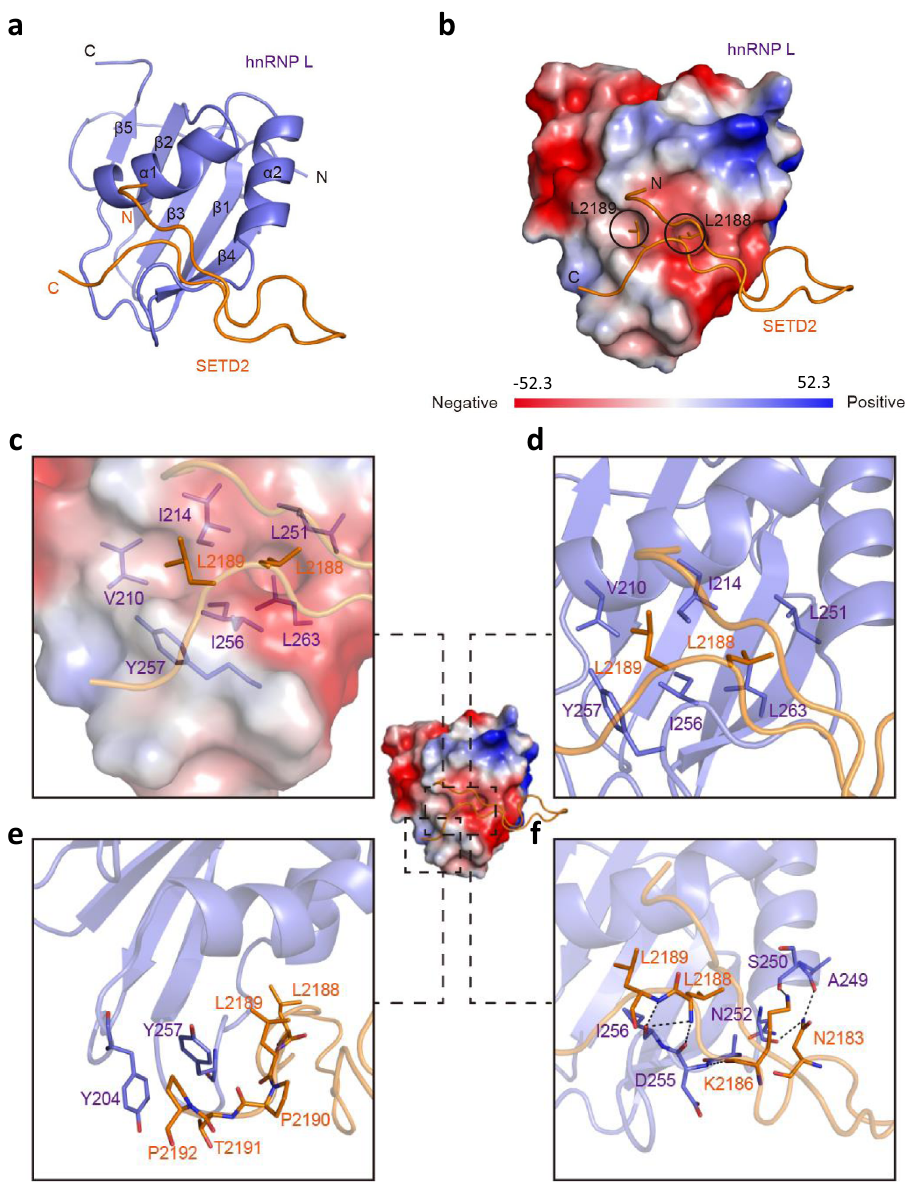
Fig. 2 The crystal structure reveals the molecular basis of hnRNP L-SETD2 interaction. a Ribbon representations of hnRNP L RRM2 bound to the SETD2 2167 – 2192 peptide. hnRNP L is colored in purple and the bound SETD2 2167 – 2192 peptide is colored in orange. b The SETD2 2167 – 2192 peptide is represented as ribbons on the molecular face of hnRNP L RRM2. The sidechains of SETD2 Leu2188 and SETD2 Leu2189 are shown as sticks. Red and blue colors denote negative and positive surface charges, respectively. The electrostatic potential surfaces were generated with PyMol at the contouring value of the potential from − 52.3 to 52.3 kTe − 1 . c – f Closeup views of the interactions between hnRNP L and the SETD2 2167 – 2192 peptide. (Left) The van der Waals surface views of hnRNP L-SETD2 2167 – 2192 . hnRNP L (purple) and SETD2 2167 – 2192 (orange) are shown as ribbons with selected sidechains as sticks. The van der Waals surface of the hnRNP L is depicted as a semitransparent skin. The SETD2 peptide is represented as a stick diagram (orange). (Right) Hydrogen bonds are shown as black dashed